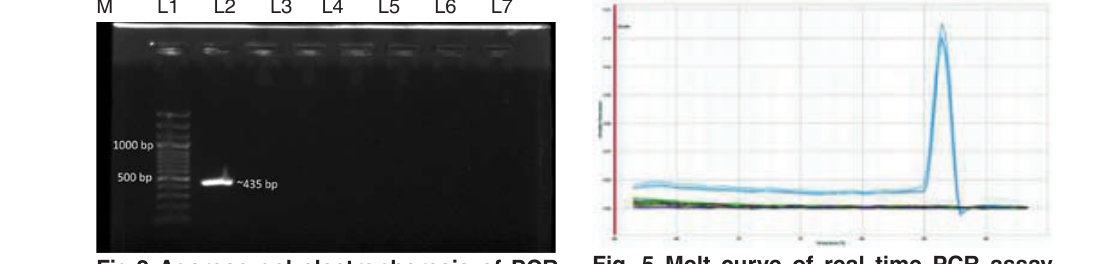
Fig. 5 Melt curve of real time PcR assay for SapB2 gene from positive control and clinical samples